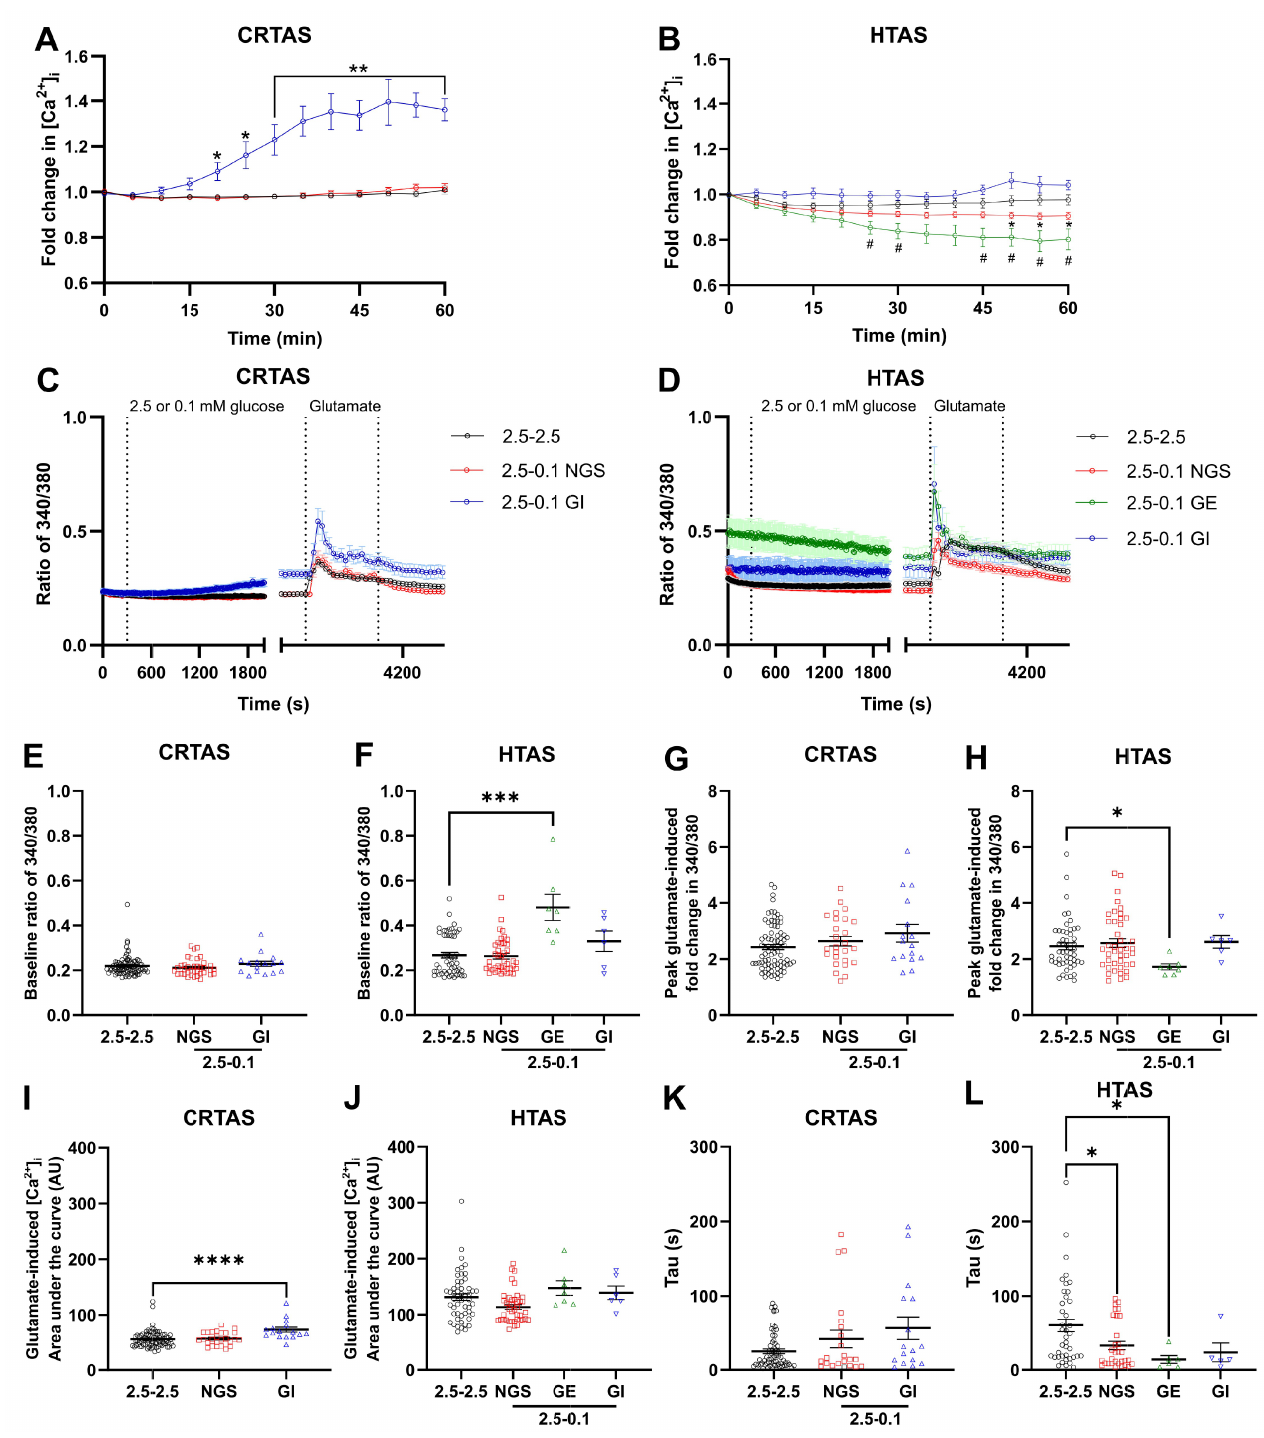
Figure 2. One hour of low glucose changes calcium levels of glucose-sensitive cortical and hypotha- lamic astrocytes. Primary cortical (CRTAS) and hypothalamic (HTAS) astrocytes were loaded with Fura-2 calcium sensitive dye for 1 h in 2.5 mmol/L glucose-containing normal saline before imaging. After 6 min of imaging in 2.5 mmol/L glucose the cells were either maintained in 2.5 mmol/L glu- cose (CRTAS n = 83 cells across 7 coverslips; HTAS n = 51 cells across 7 coverslips) or decreased to 0.1 mmol/L glucose (CRTAS n = 44 cells across 6 coverslips; HTAS n = 55 cells across 10 coverslips) for 1 h. Cells were then treated with glutamate (100 µ mol/L) for 3 min before washout and